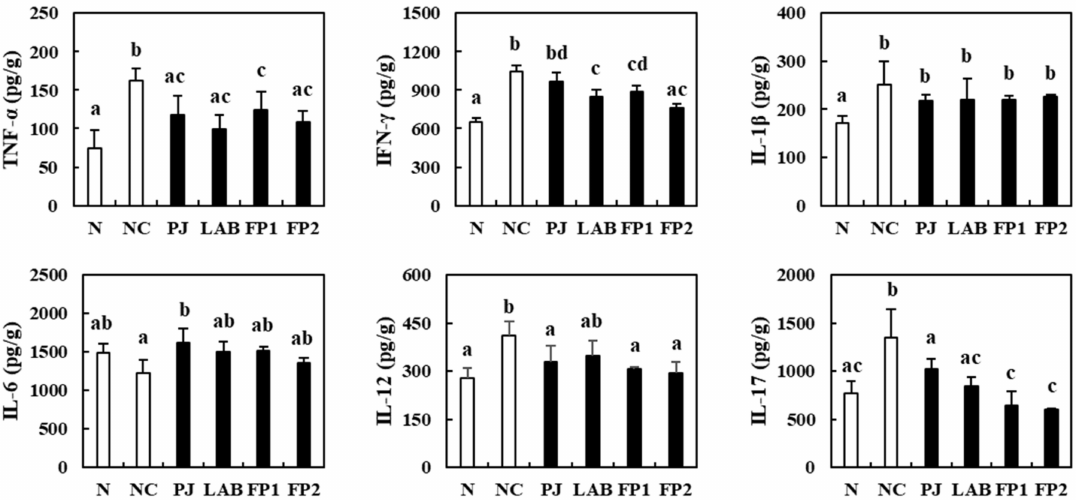
Figure 7. Effects of FP on colonic cytokines of DSS-induced colitis mice. N, normal group, non-DSS treatment; NC, negative control group, DSS treatment and supplementation with distilled water; PJ; Prunus mume juice (PJ) group, DSS treatment and supplementation with 200 mg/kg of 2.5% PJ; LAB, lactic acid bacteria (LAB) group, DSS treatment and supplementation with 200 mg/kg of L. plantarum and L. casei suspended by distilled water; FP1, low dose of fermented Prunus mume juice (FP) group, DSS treatment and supplementation with 100 mg/kg of FP; FP2, high dose of FP group, DSS treatment and supplementation with 200 mg/kg of FP. Data values are expressed as the means ± S.D. ( n = 6). The data are analyzed with one-way ANOVA and different letters on the bar show the difference in Duncan’s multiple range test ( p <